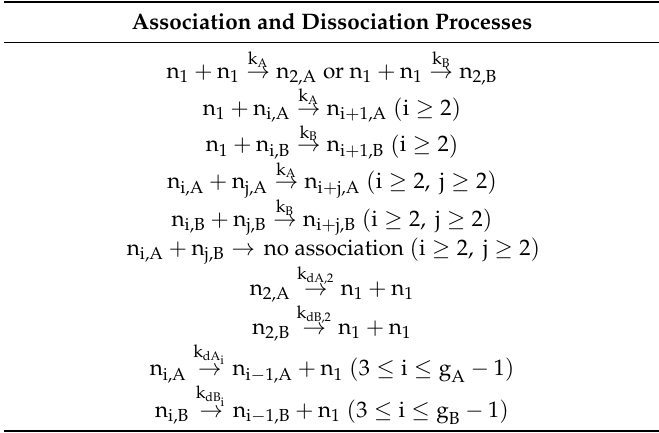
Table 1. Various association and dissociation processes for polymorph